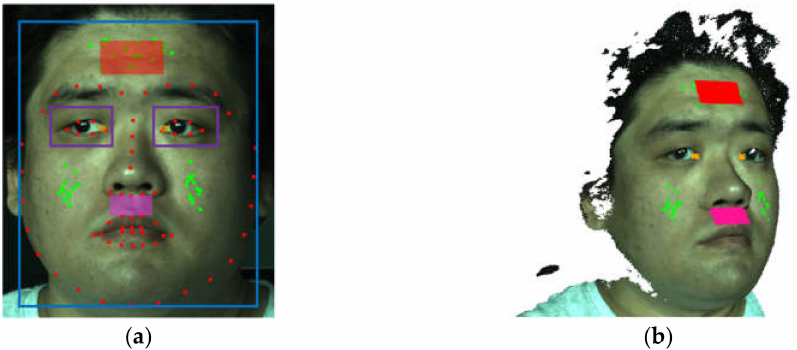
Figure 4. ( a ) Selection of region of interest (ROI) and feature points on the basis of face analysis in 2D color image, ( b ) transformation of ROI and feature points into 3D space.